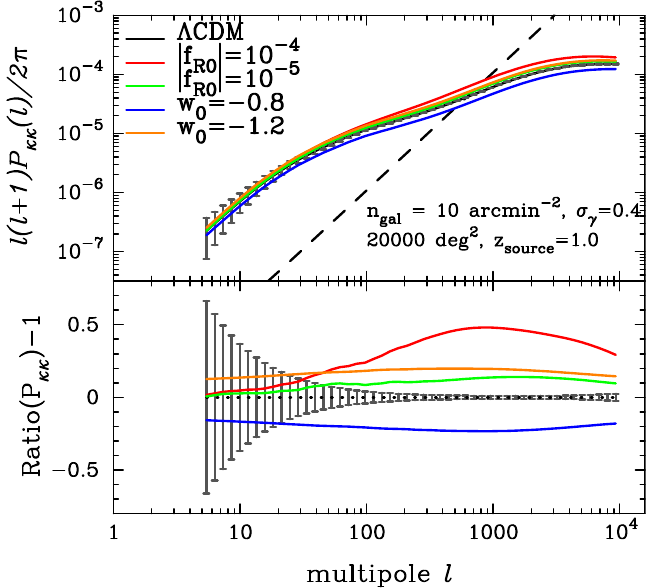
Fig. 2 Top panel: convergence power spectra for f ( R ) models (see Sect. 7.4.1), dynamical dark energy models and the Λ CDM standard model. Error bars are for the survey indicated on the figure—sky coverage of 20,000 square degrees with a galaxy density number of 10 per arcminutes squared. The dashed line corresponds to the shot noise term of auto power spectrum. Bottom panel: Ratio between Λ CDM model and f ( R ) models or w CDM models. Image reproduced with permission from Shirasaki et al. (2016), copyright by the